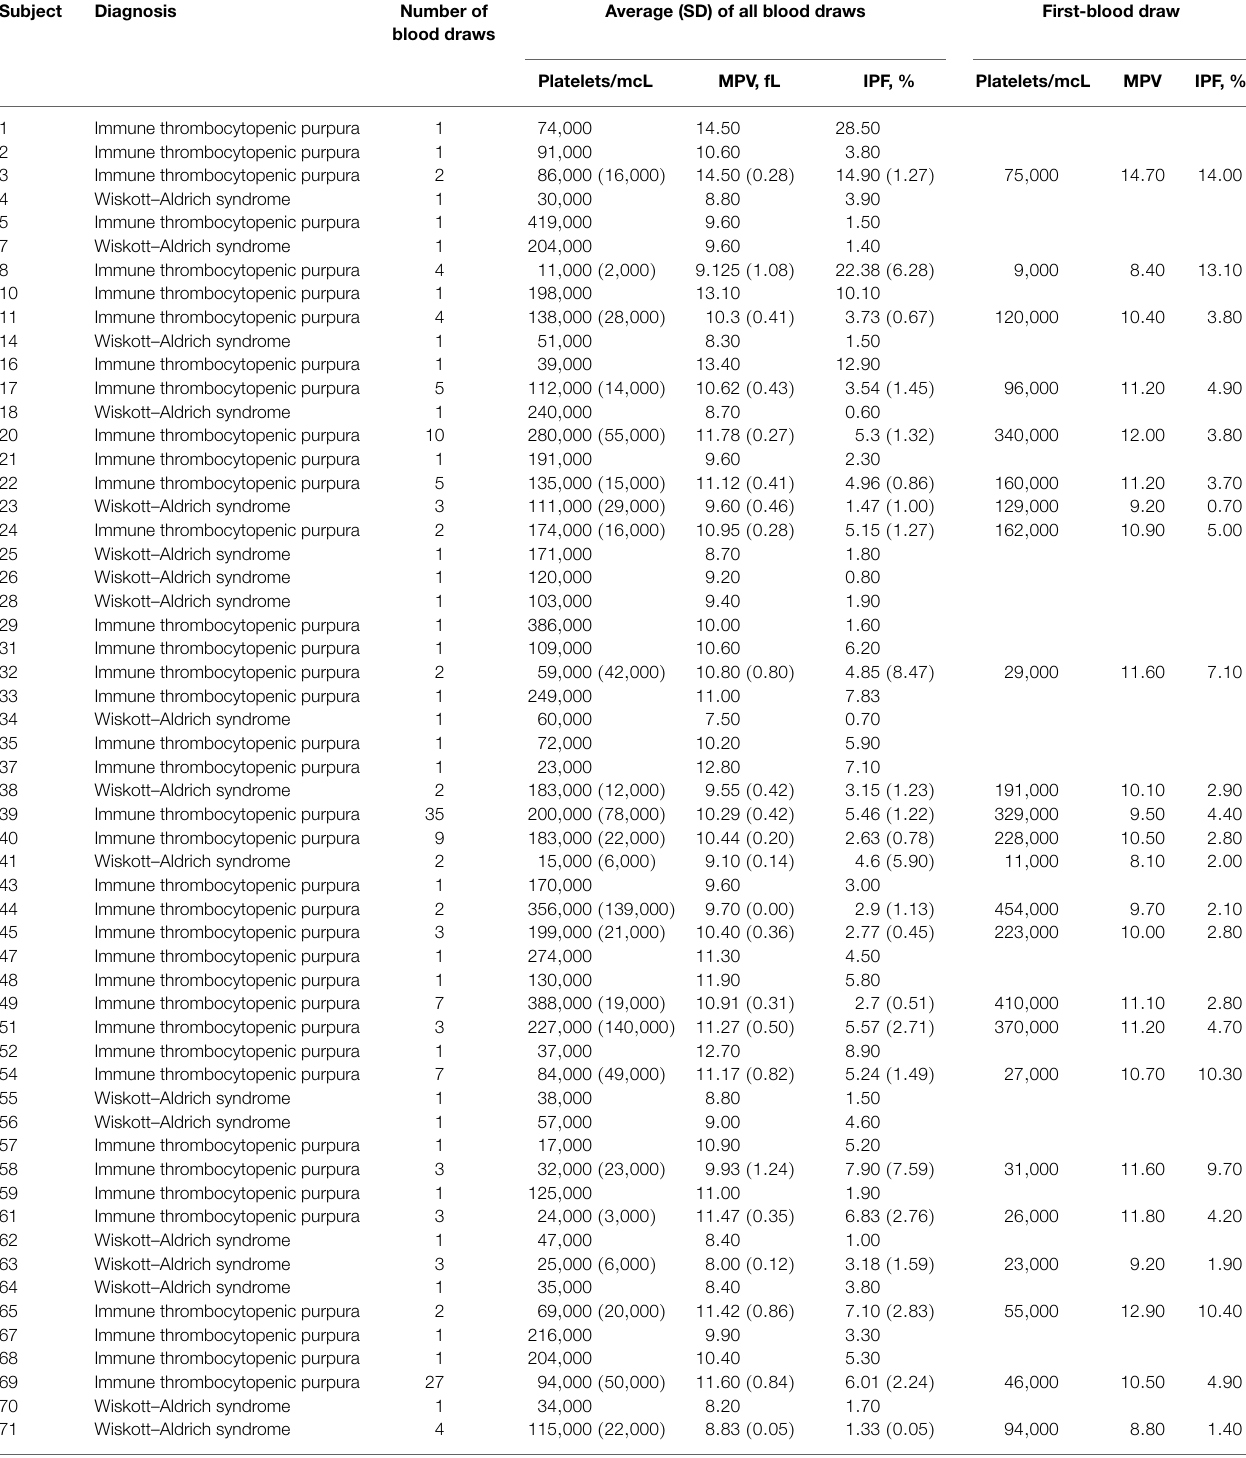
TABLE 2 | Final data sets for the derivation cohort